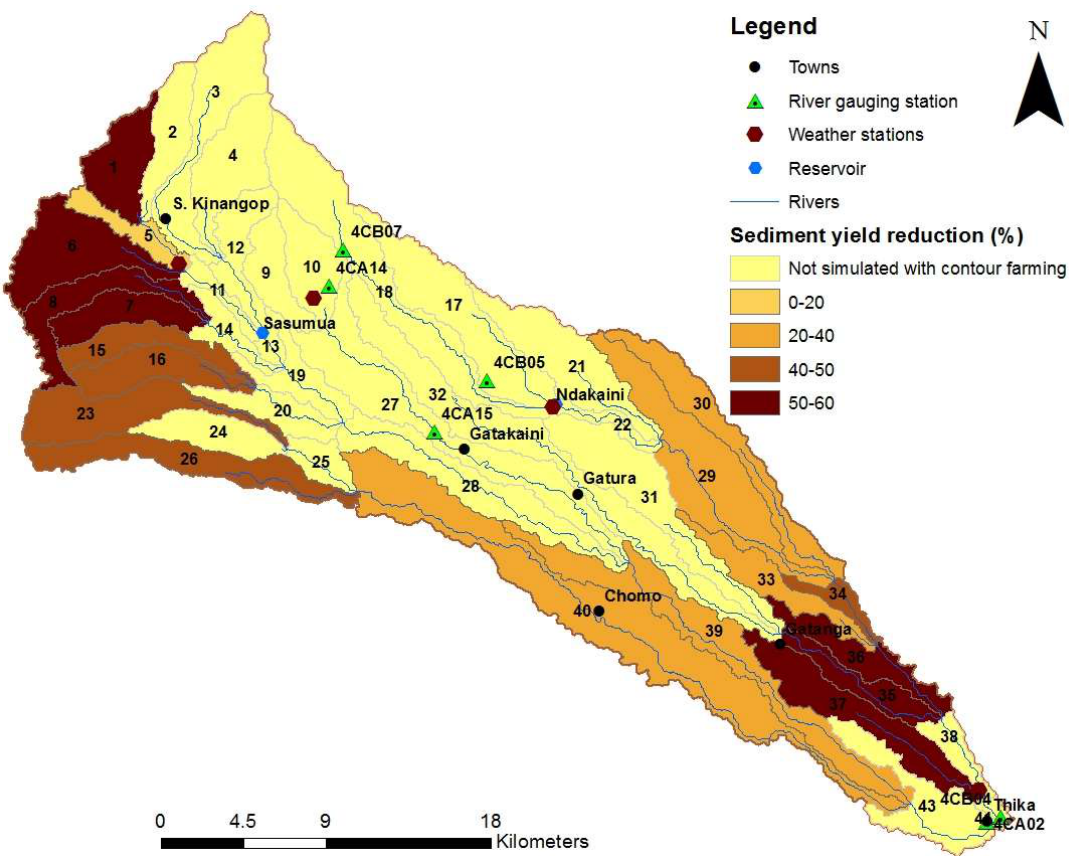
Figure 7. Simulation results of sediment reduction after contour farming.